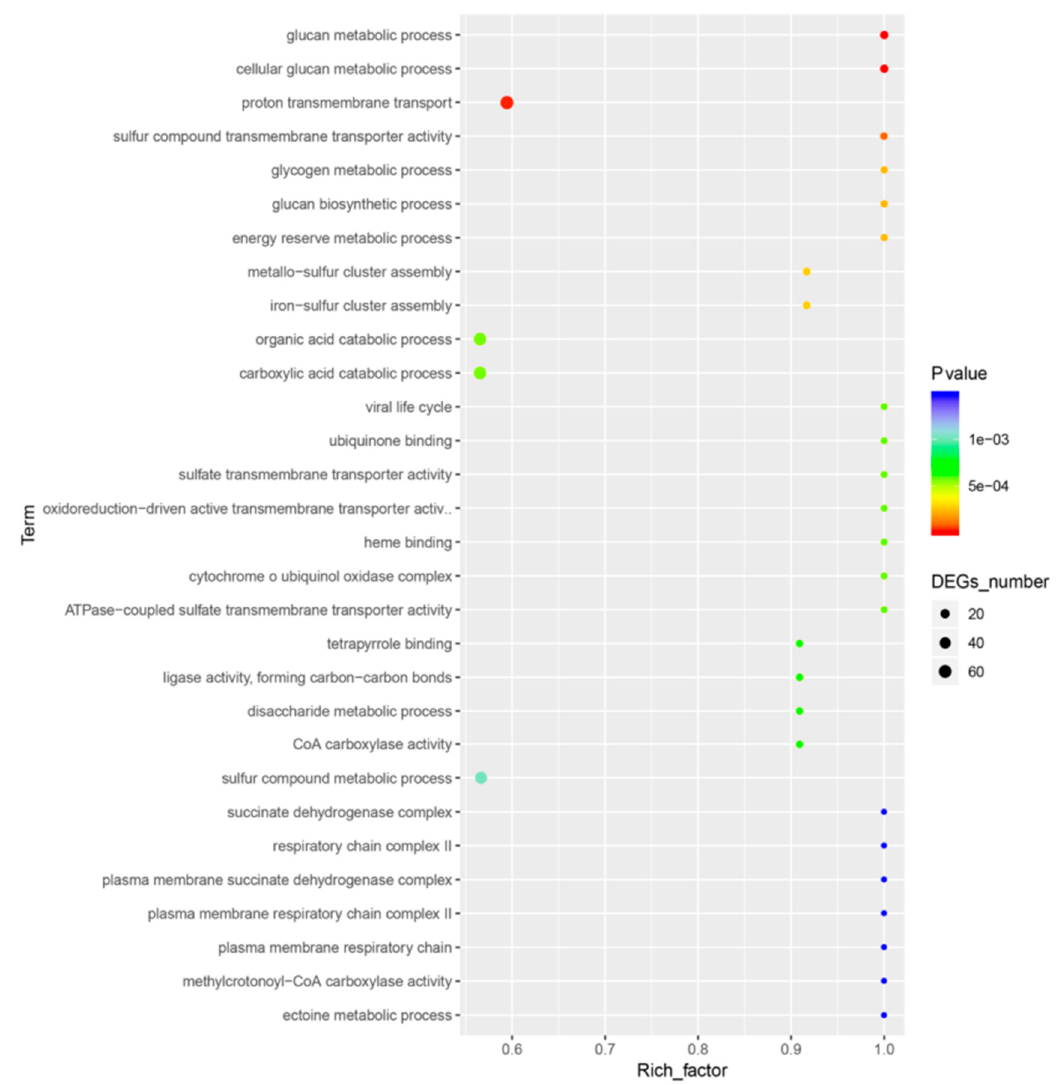
Figure 4. Top Gene Ontology enriched pathways. A large rich factor indicates a high degree of enrichment.